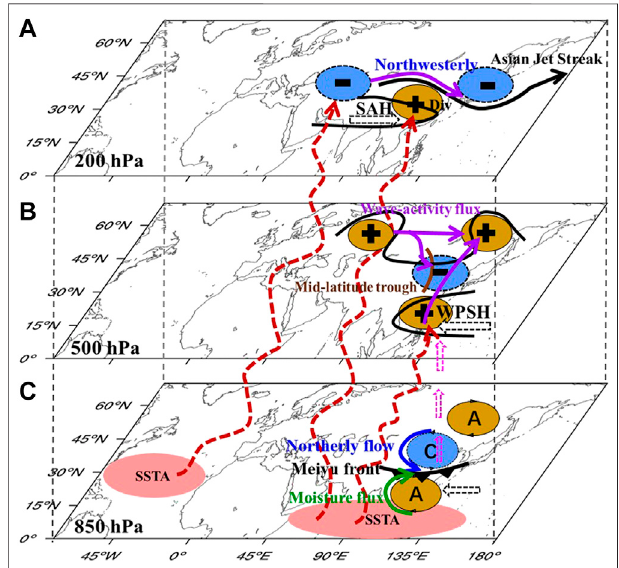
FIGURE11| Schematicillustrationofthecollaborativeevolutionofwave trains in the upper and lower troposphere during the Meiyu season in the mid July of 2020. The symbol “–” ( “ + ” ) represents the negative (positive) geopotential height anomaly. “ C ” ( “ A ” ) denotes the abnormal cyclone (anticyclone). “ Div ” in (A) denotes divergence. The purple arrows represent wave-activity fl ux. The black blank dashed arrows represent the movement of the key systems. The red dashed curve arrows represent the effects of SST. The black thin and thick lines denote the SAH and Jet streak in (A) , respectively. In (B) , the black thin lines denote WPSH and trough/ridge at the middle and high latitudes, and the brown curve represents the trough line. In (C) , the blue arrow represents the northerlies from mid and high latitudes. The black triangle curve denotes the Meiyu front. The green arrow represents the water vapor fl ux. The pink dotted arrows denote ascending